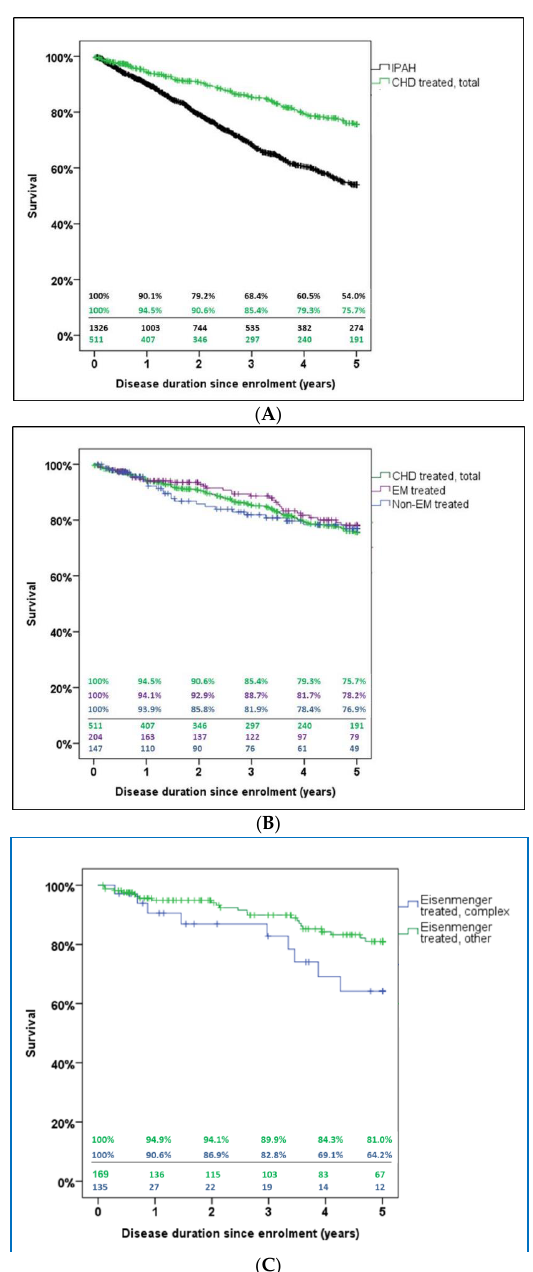
Figure 5. Kaplan–Meier 5-year survival estimates. ( A ) Comparison of all patients who underwent targeted PAH treatment for either congenital heart disease-associated pulmonary hypertension (CHD treated, total) or incident idiopathic PAH. The 5-year Kaplan–Meier survival estimate was 76% for PAH due to CHD and 54% for idiopathic PAH ( p < 0.001). ( B ) Comparison of subgroups of patients with CHD and PAH under targeted PAH medication: (1) CHD-treated, total (green); (2) Eisenmenger-patients-treated (EM treated; purple); (3) non-Eisenmenger-PAH-patients (Non-EM treated; blue). The overall 5-year survival estimate was 76%, compared with 78% for the Eisenmenger patients, and 77% for the non-Eisenmenger-PAH-patients ( p = 0.384). ( C ) Comparison of subgroups of patients with Eisenmenger syndrome due to complex or simple CHD. The 5-year Kaplan–Meier survival estimate was 81% for Eisenmenger syndrome caused by simple CHD and 64% for Eisenmenger syndrome due to complex CHD ( p = 0.063). Kaplan–Meier survival estimates (top) and number of cases still under observation (bottom) are shown in tabular form. Abbreviations: CHD, congenital heart disease; non-EM, non-Eisenmenger-PAH-patients; PAH, pulmonary arterial